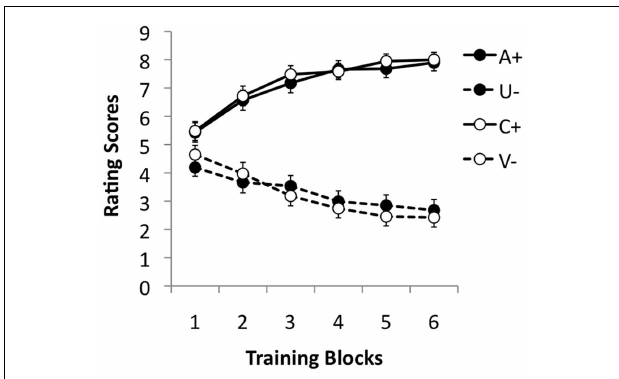
FIGURE 3 | Mean rating scores forAZ + ,AP − , BX − , and CY + during the four blocks of the training stage . A rating of 9 reflects expectation of a positive image, 1 of a neutral image, and 5 uncertainty; 95% confidence intervals are presented.